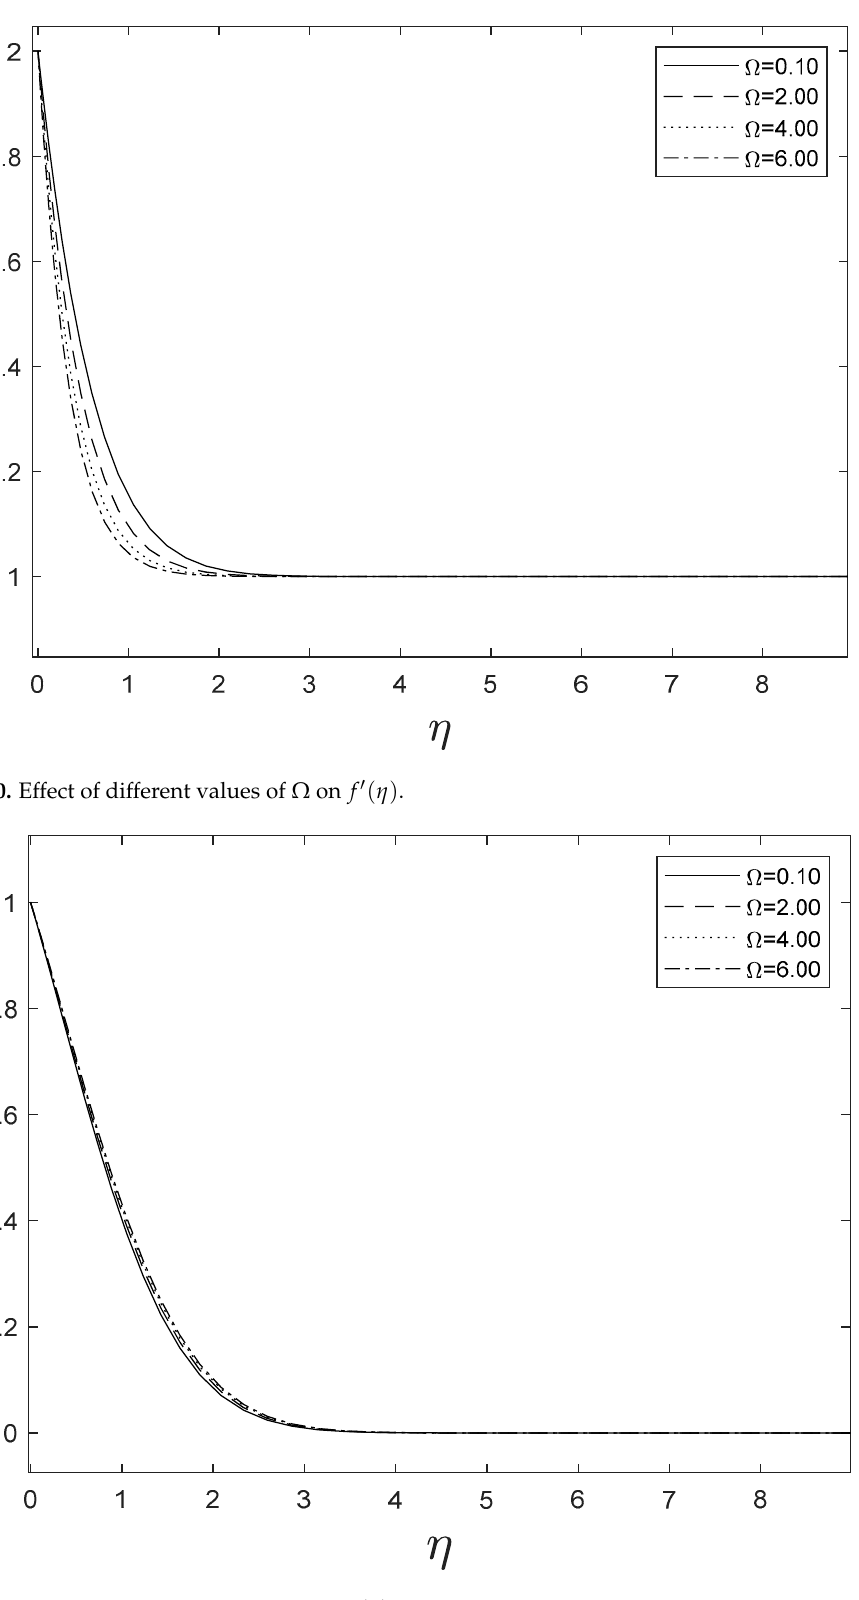
Ω θη Ω on θ ( η ) on ( ) . Figure 21. Effect of different values of Ω θη on ( ) .